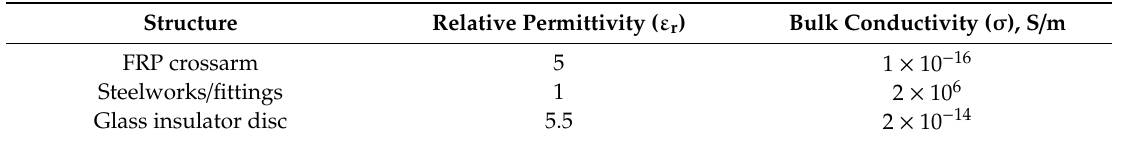
Table 2. Material-based parameters.